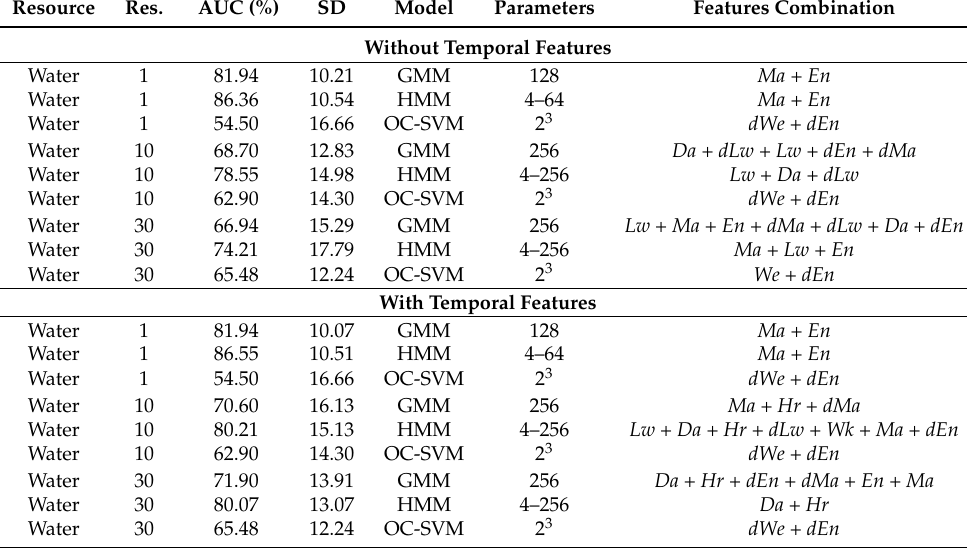
Table 4. Best results and corresponding features’ combination achieved for each resource and resolution ( Res. ) of the Almanac of Minutely Power dataset (AMPds) dataset. The column “ Parameters ” reports the number of Gaussians, the states and Gaussians number and the γ value for GMM, HMM and One-Class (OC)-SVM, respectively.